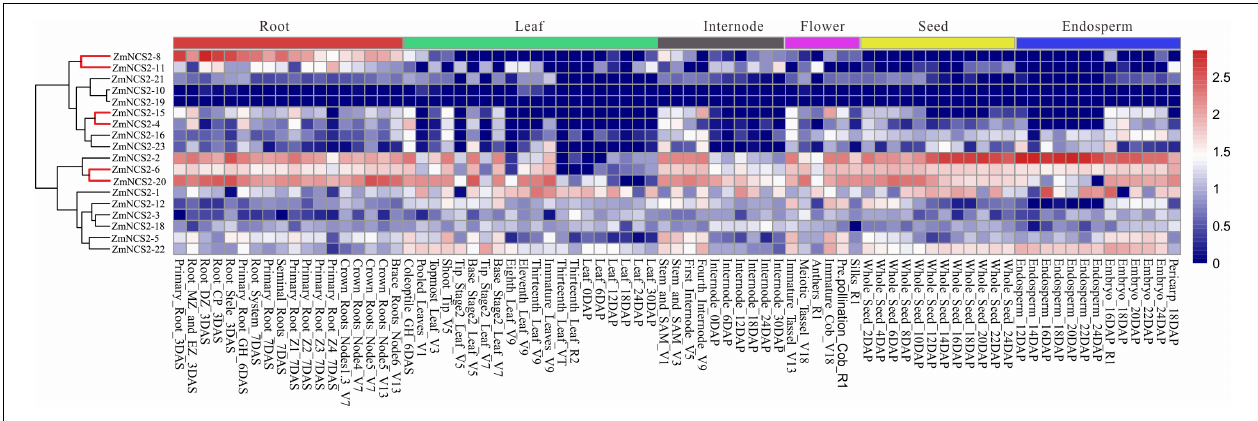
FIGURE 6 | Expression profiles of NCS2 genes in different tissues. Gene expression was analyzed in the roots, leaves, internodes, flowers, seeds, and endosperm. Genome-wide microarray data were obtained from the NimbleGen microarray provided by Stelpflug et al. (2016).